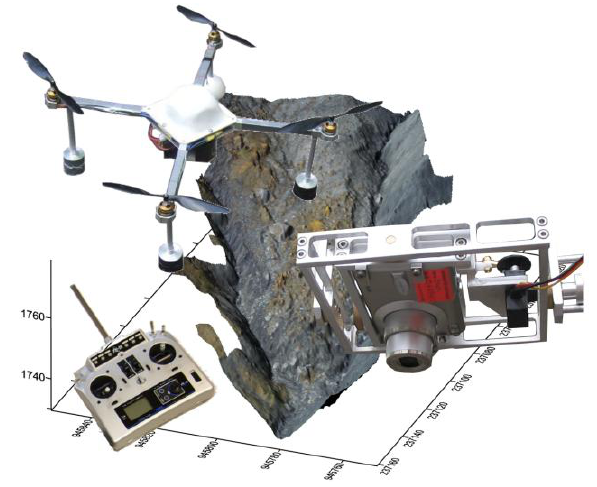
Figure 2. UAV-system for landslide investigations